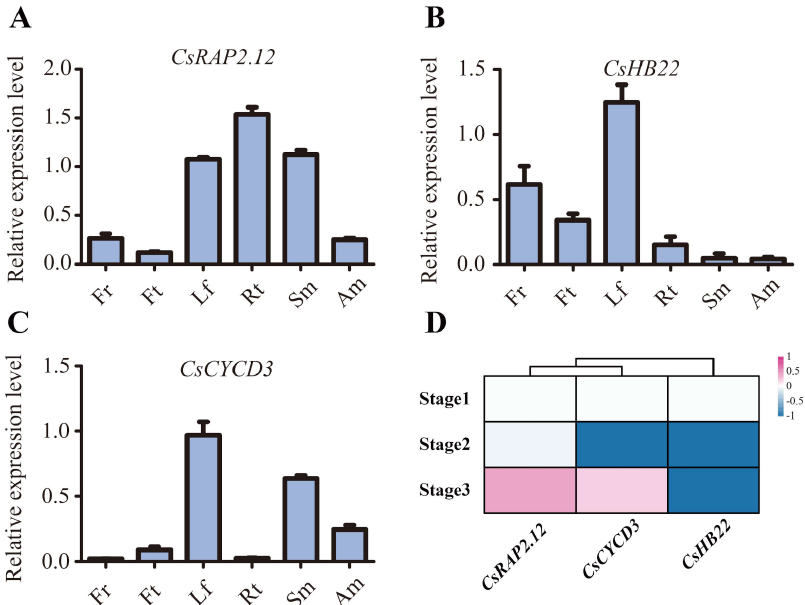
Figure 8. Expression of CsRAP2.12 , CsHB22 , and CsCYCD3 in different Citrus sinensis tissues and under floral inductive water deficit conditions ( A – C ) Real time PCR investigation for CsRAP2.12 ( A ), CsHB22 ( B ), and CsCYCD3 ( C ) expressed in different tissues of sweet orange: leaf (Lf), flower (Fr), fruit (Ft), stem (Sm), apical meristem (Am), and root (Rt). CsActin was used as internal control; Values are the means ± SE of at least three replications for the relative expression. ( D ) Cluster analysis of CsRAP2.12 , CsHB22 and CsCYCD3 expression based on log 2 ratio ≥ 1. Bar denotes different expression levels and colors indicate relative signal intensities. Stage 1: one week before water deficit; stage 2: one week after beginning of water deficit; stage 3: one week after release of water deficit